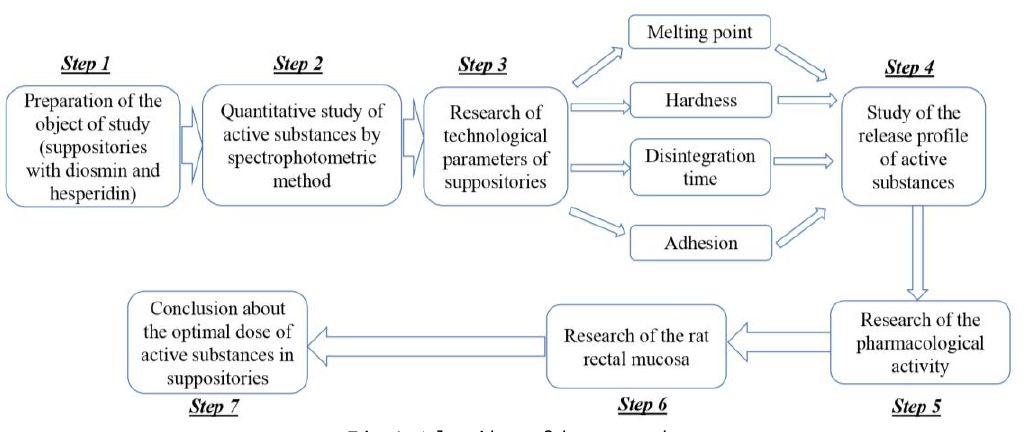
Fig. 1. Algorithm of the